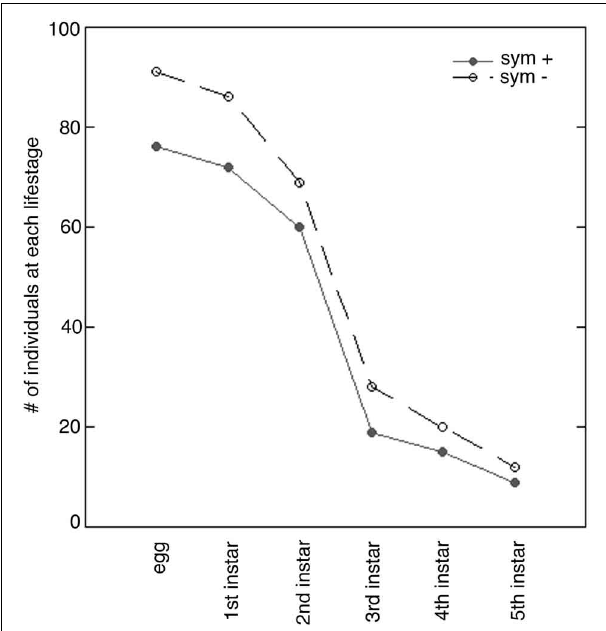
FIGURE 7 | Survivorship of symbiont-endowed (sym + ) and symbiont-deprived (sym − ) Sibaria englemani nymphs. Number of nymphs per instar from emergence through the 5th instar indicates high mortality at the 2nd stadium when reared in captivity. Parallel survivorship curves represent no significant difference between symbiont-endowed (filled circles) and symbiont-deprived populations (unfilled circles; p = 0 . 96, Pearson’s chi-squared test). FIGURE 8 | Line drawings of the digestive tract of four species